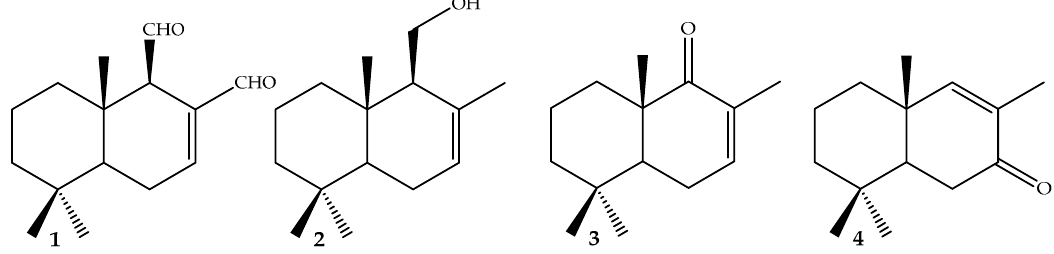
Figure 1. Chemical structures of drimanes: ( 1 ) polygodial, ( 2 ) drimenol, ( 3 ) nordrimenone, and ( 4 ) isonordrimenone.